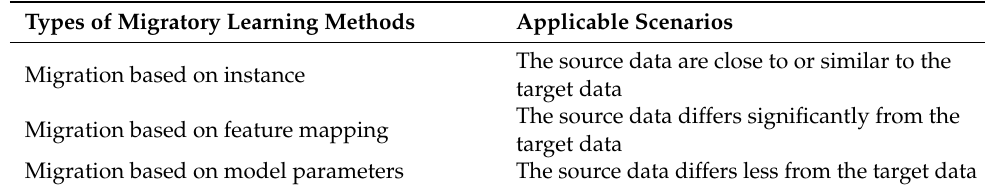
Table 1. Scenarios for migration learning